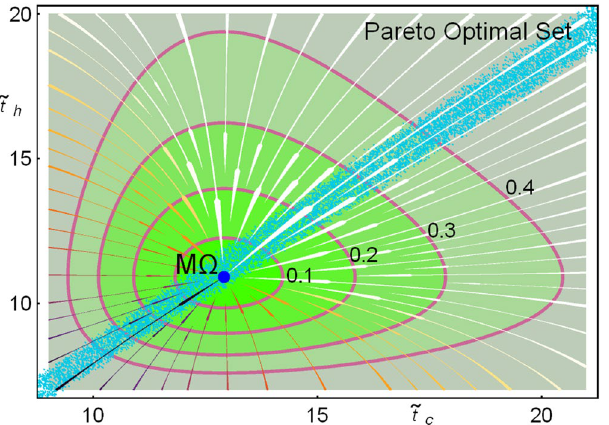
t 2 . Level curves of constant =